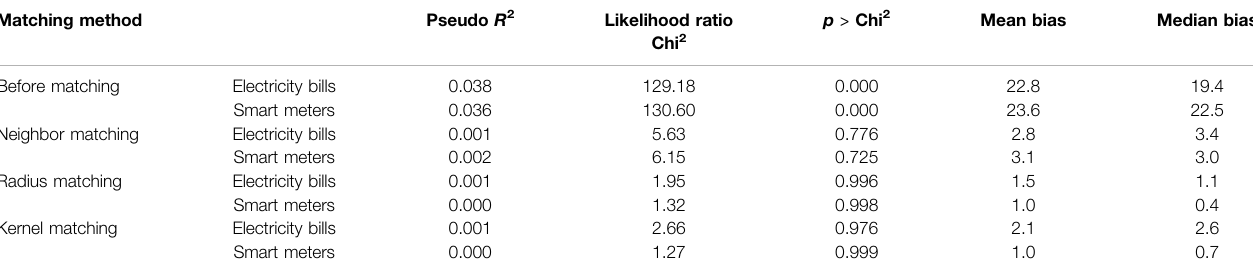
TABLE 7 | Statistical tests to evaluate the matching. Matching method